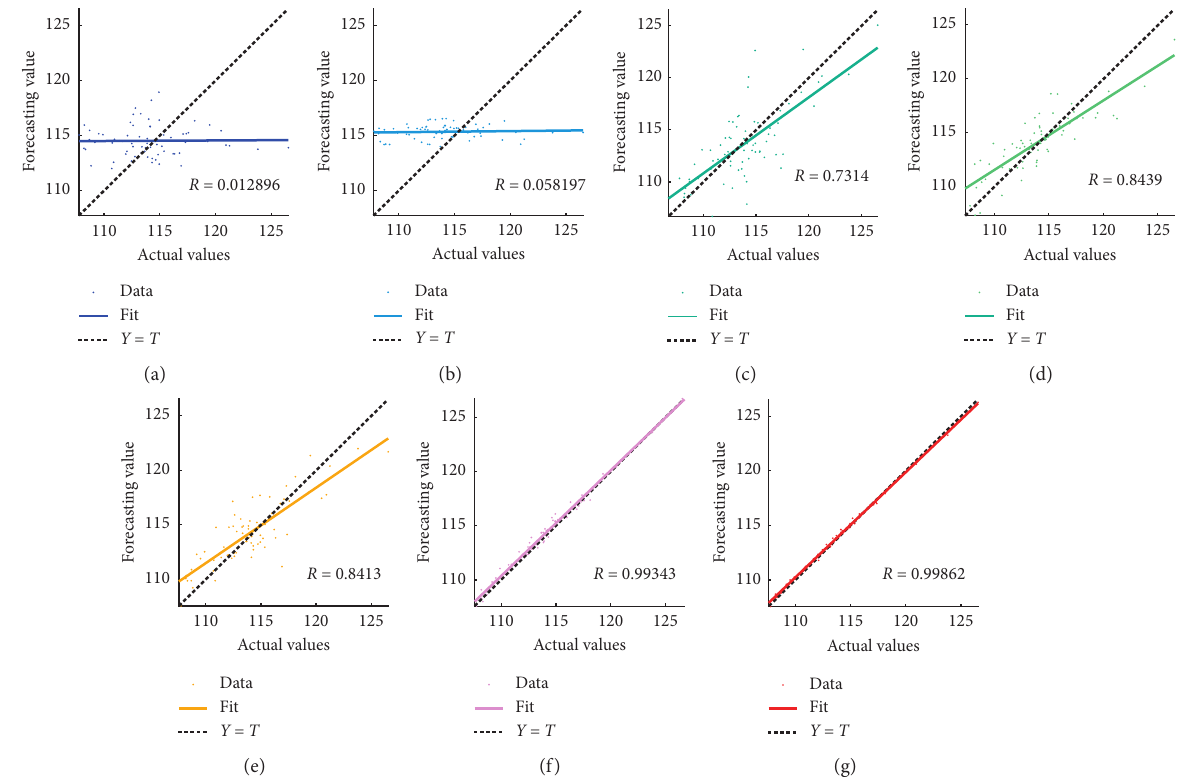
Figure 10: Scatter plots illustrating the fitting degree of each model in the order of Table